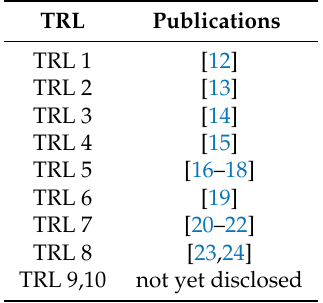
Table 7. The MagLev 2 -Cobra evolution framed in the TRL